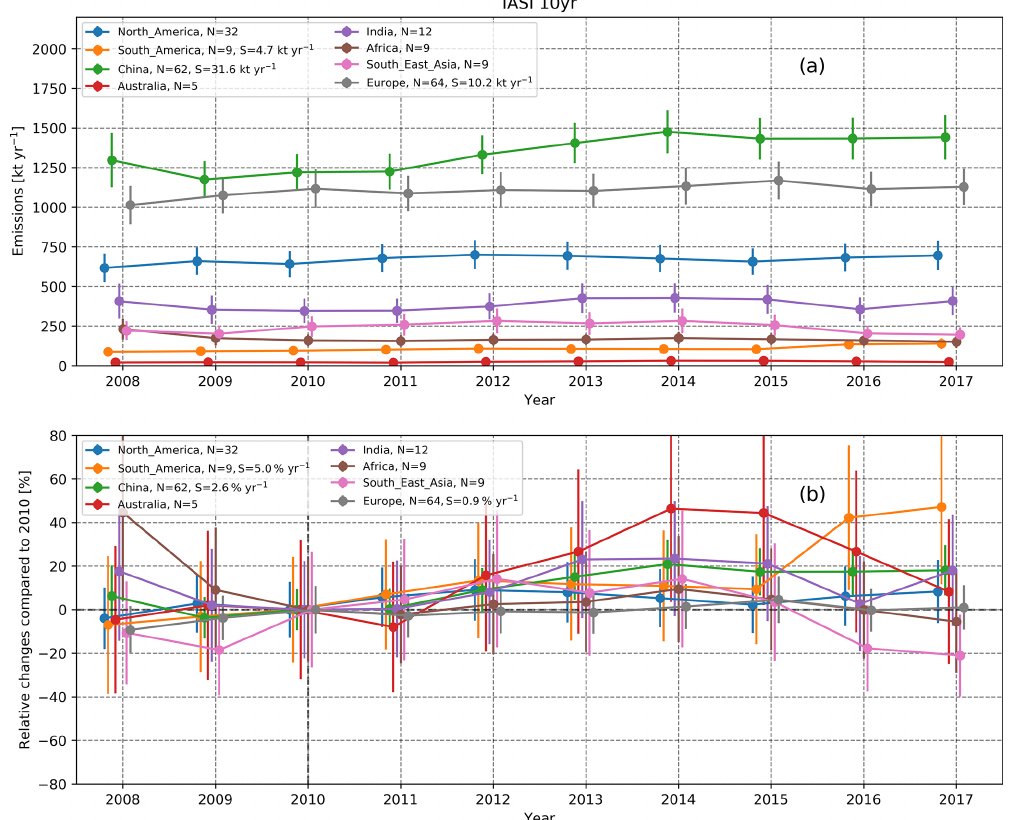
Figure 12. Regionally summed annual IASI-A NH 3 emission estimates. The plot in panel (a) shows the total emissions per year for each region, with N the number of sources used for each sum and S the Sen slope estimate of the 10 years of data for all cases with a significant Mann–Kendall trend test. The error bars represent the uncertainty of each of the individual sources added in quadrature. The plot in panel (b) shows the emissions normalized by base year 2010, with N the number of sources used for each sum and S the Sen slope estimate of the 10 years of data for all cases with a significant Mann–Kendall trend